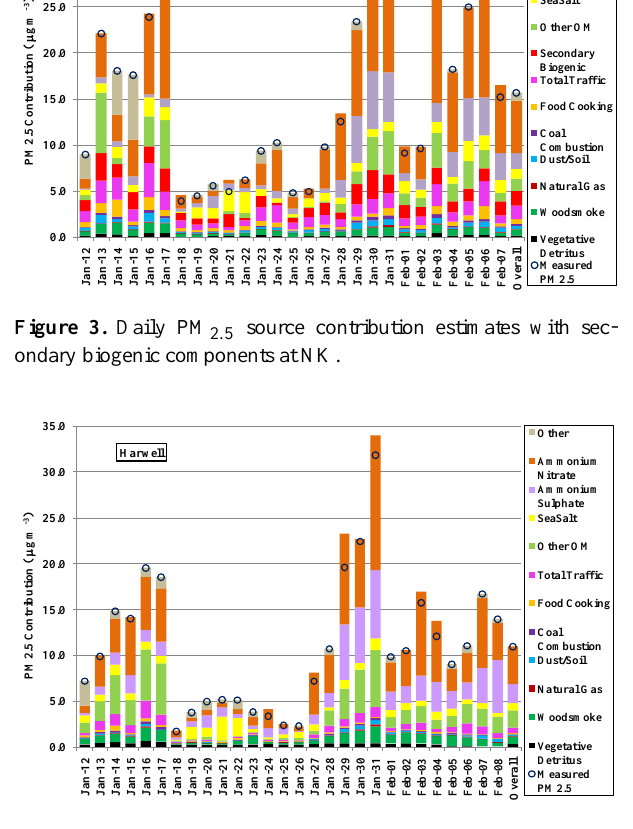
(0.54 µg m − 3 ) and food cooking (0.39 µg m − 3 ), the